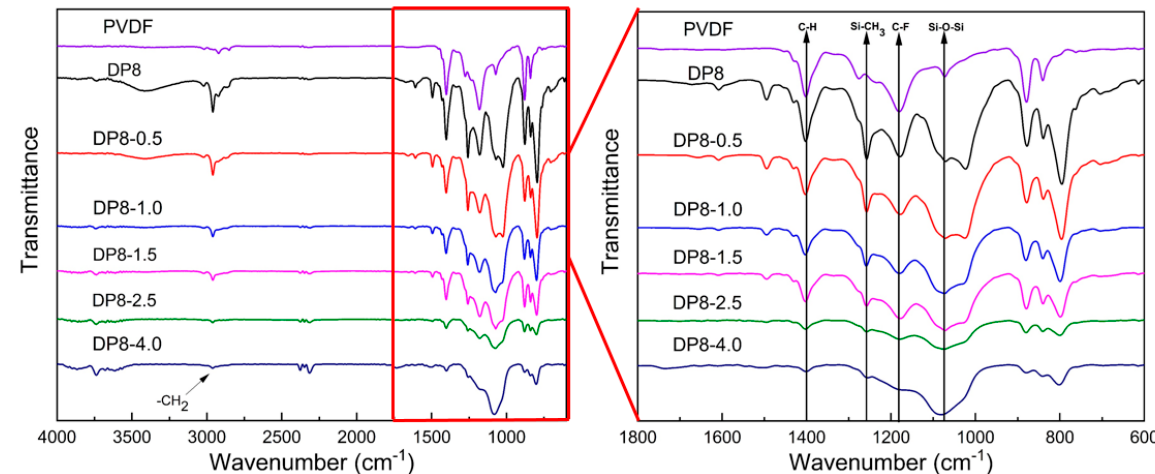
Figure 1. FTIR of pure PVDF nanofiber membrane and DP8–X fiber membrane. The represented element distribution of PVDF/DP8/SiO 2 composite film (DP8–1.5)